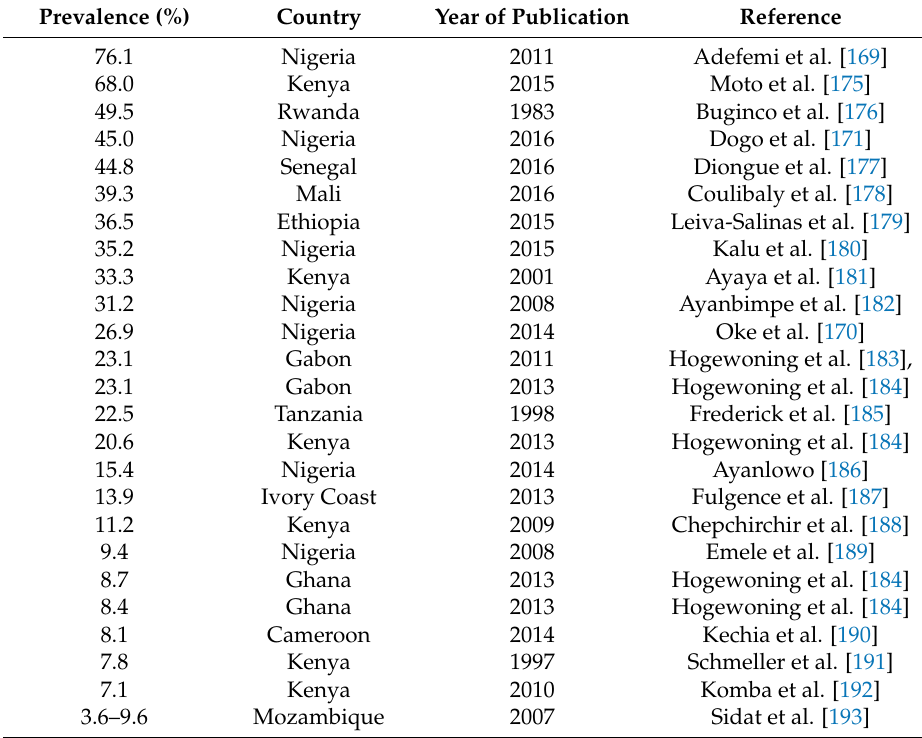
Table 9. Prevalence of Tinea capitis among school-age children in sub-Saharan Africa. Prevalence (%)